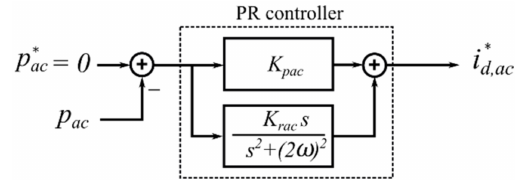
Figure 7. Power ripple controller.